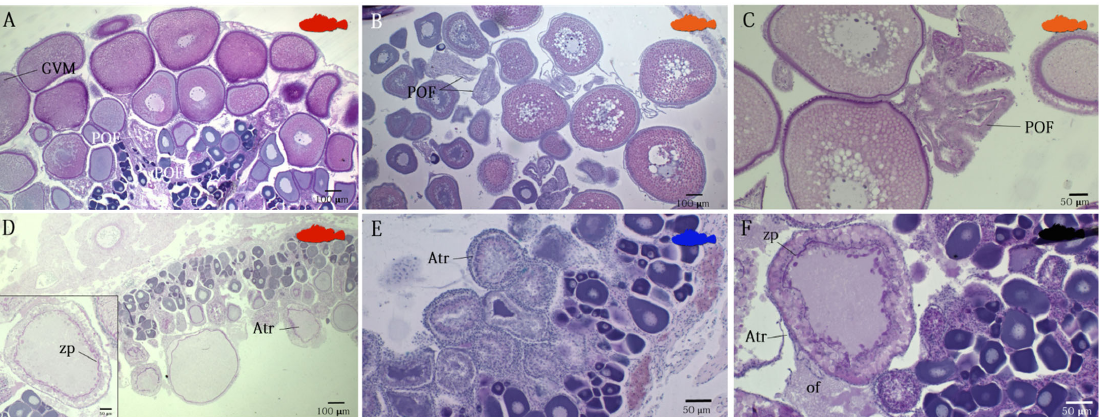
Figure 6. Post ‐ ovulatory follicles and atretic oocytes in Scorpaena genus and in Helicolenus dactylopterus (AB/PAS staining). ( A ) Actively spawning females of S. scrofa , ( B ) H. dactylopterus and ( C ) S. elongata that have already spawned for the presence of new post ‐ ovarian follicles. Atretic oocytes with irregular contour and zona pellucida which are PAS ‐ positive and with partially liquefied yolk globules at the end of spawning in ( D ) Scorpaena scrofa , ( E ) Scorpaena notata, and ( F ) Scorpaena porcus. Atr, atretic oocyte; GVM, germinal vesicle migration stage; of, ovarian fluid; POF, post ‐ ovulatory follicle; zp, zona pellucida.